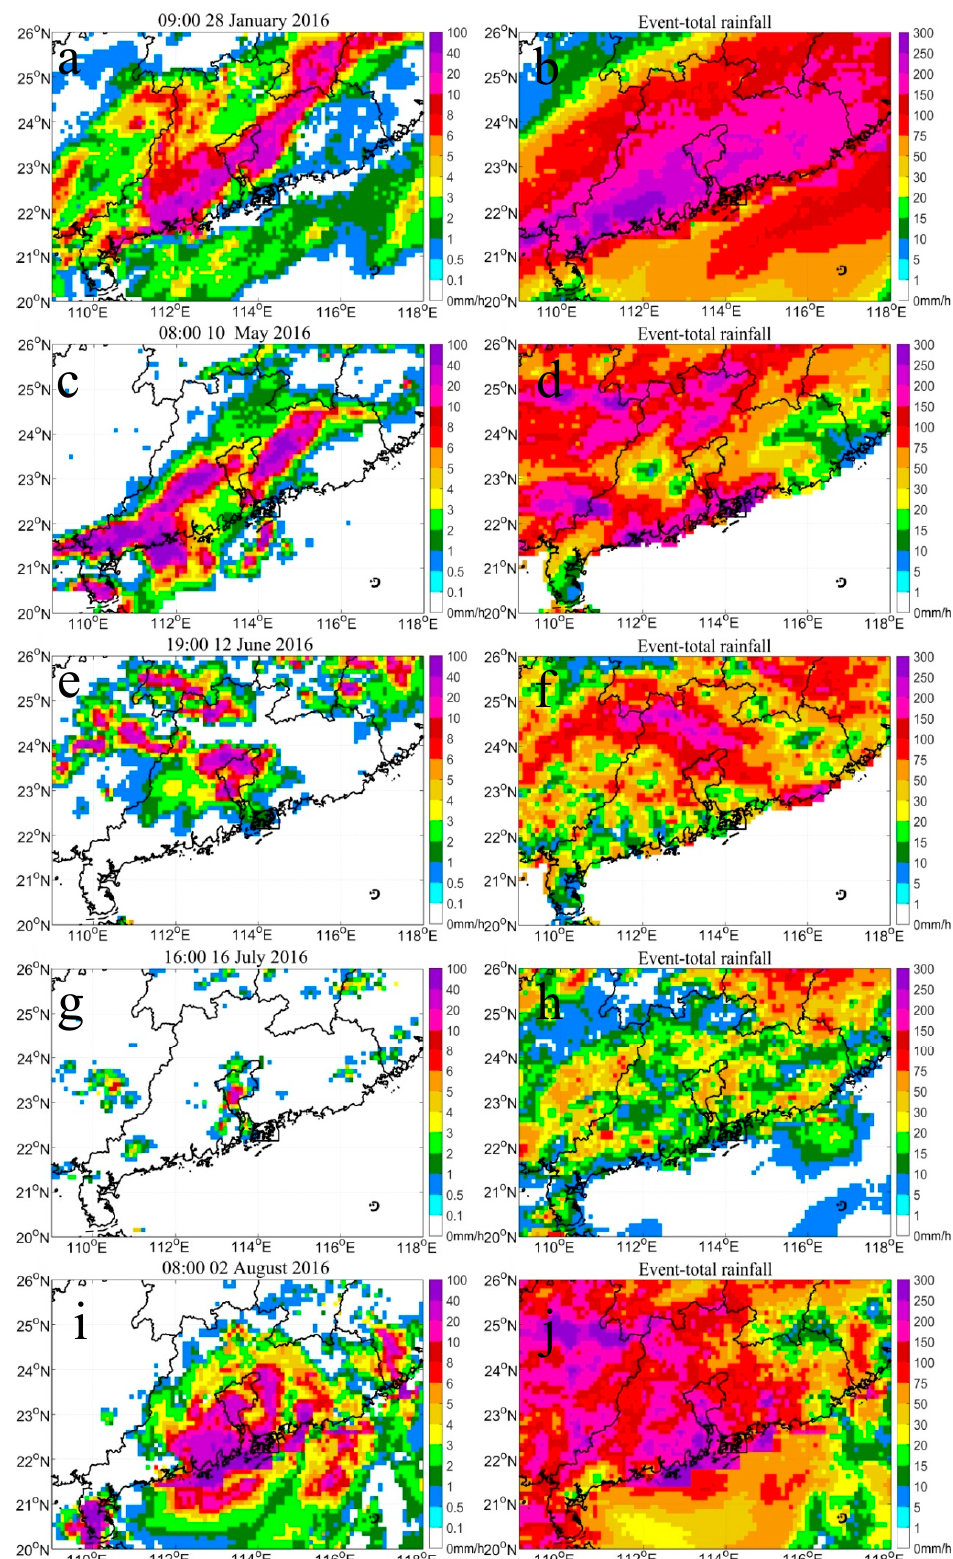
Figure 5. The spatial distribution of the peak rainfall and event-total rainfall plotted from the China Hourly Merged Precipitation Analysis (CMPA) product for five typical storm events (types) that occurred in the metropolitan areas of Guangzhou, China, that is, a warm-front storm ( a , b ), a cold-front storm ( c , d ), a monsoon storm ( e , f ), a convective storm ( g , h ), and the typhoon Nida storm ( i , j